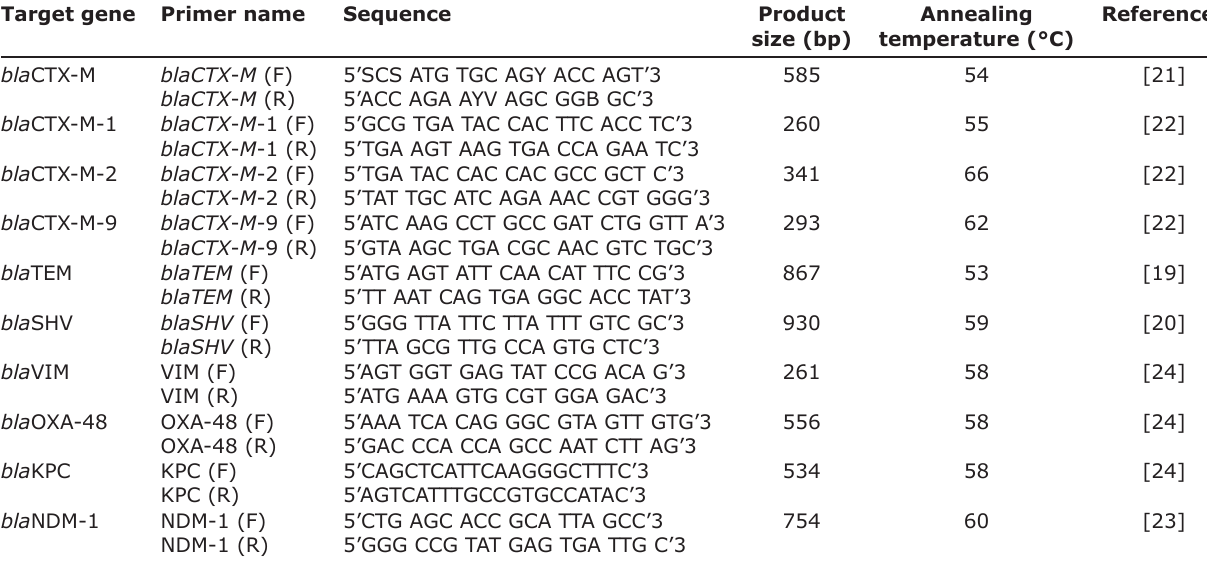
Table-1: List of primers used for molecular characterization of ESBL.